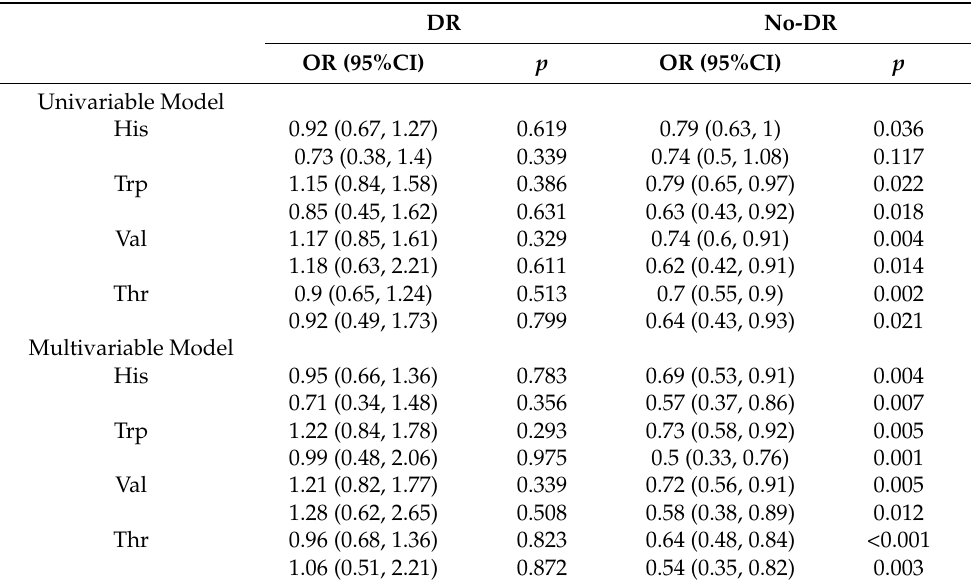
Table 5. Odds ratio of significant amino acid for the risk of diabetic nephropathy stratified by diabetic retinopathy after random forest imputation of missing